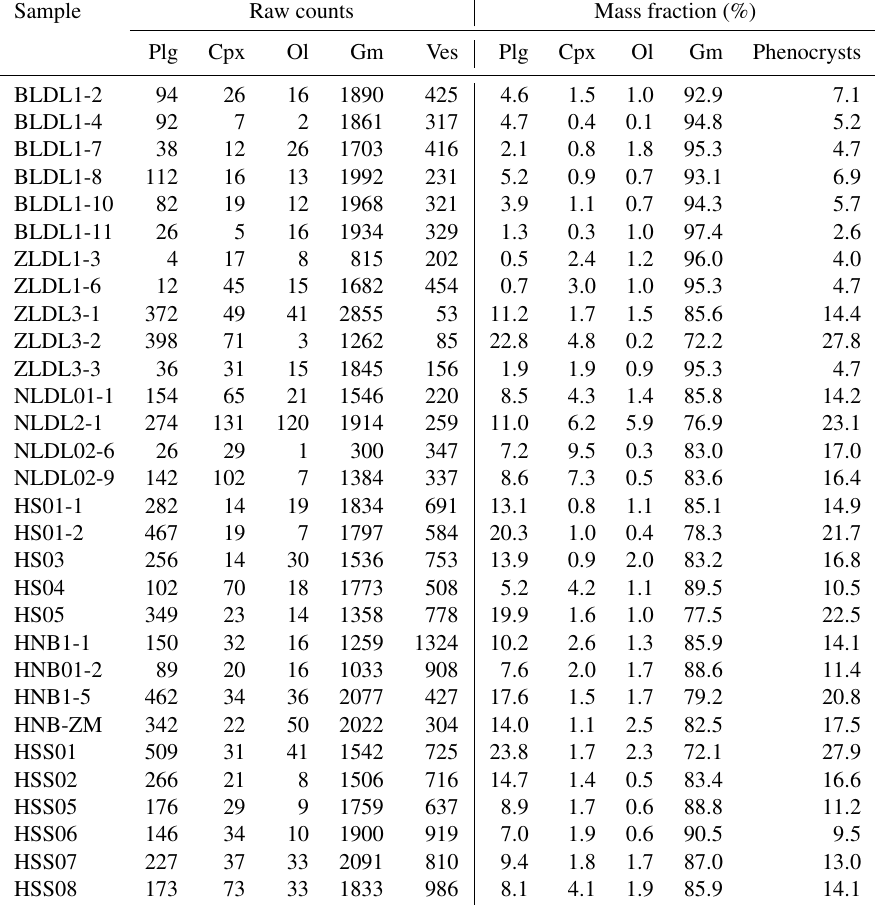
Table 1. Raw point-counting data and mass fractions for samples of the WVF.